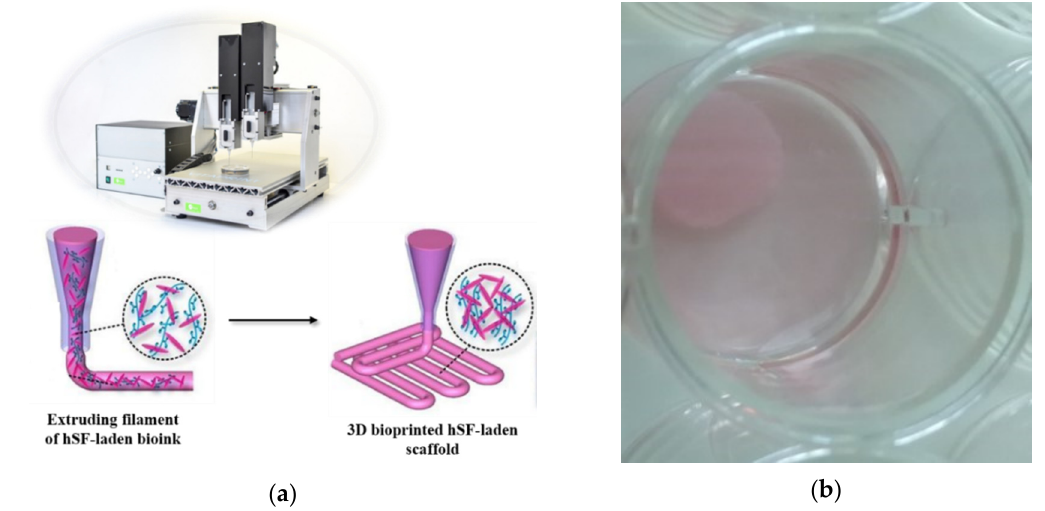
Figure 1. Fabrication of human-derived skin fibroblasts (hSF) cell-laden scaffolds: ( a ) Schematic presentation of 3D bioprinting of hSF-laden scaffold; ( b ) 3D bioprinted hSF-laden scaffold immersed in Advanced Dulbecco’s Modified Eagle Medium (ADMEM) + 5 wt.% fetal bovine serum (FBS). Additional photographs of the printed ink and bioink formulations, as well as the model used for the